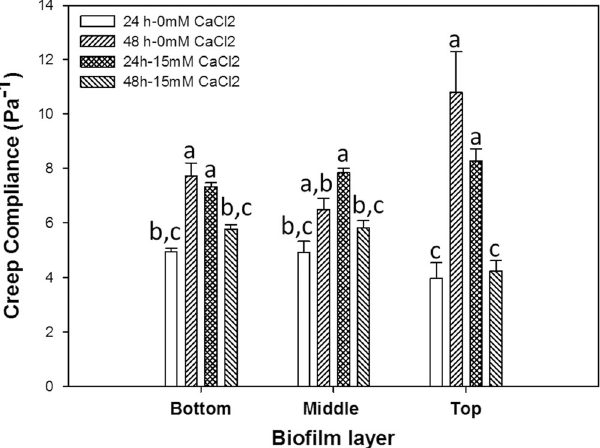
Fig. 4. Mean creep compliance of Pseudomonas fl uorescens bottom, middle and top bio fi lm layers following 24 h and 48 h-bio fi lm development under the absence and presence of CaCl 2 environ- ments. Means that do not share a letter are signi fi cantly different. Error bars represent standard error of the